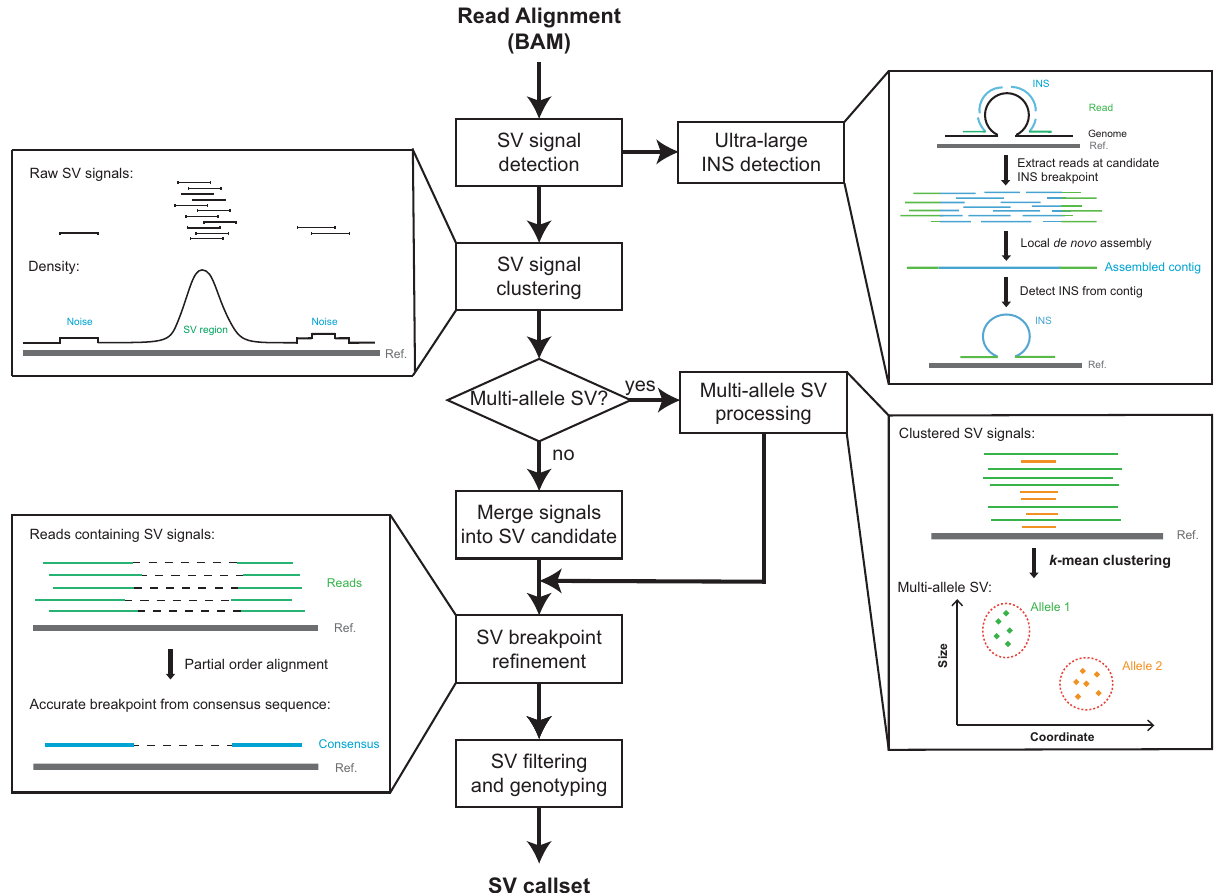
Fig.1|Work fl owofDeBreak. ThemajorstepsofDeBreakSVdiscoveryincludeSVsignaldetection,signalclustering,breakpointre fi nement,and fi lteringandgenotyping. Detailed descriptions of each step can be found in the “ Methods ”